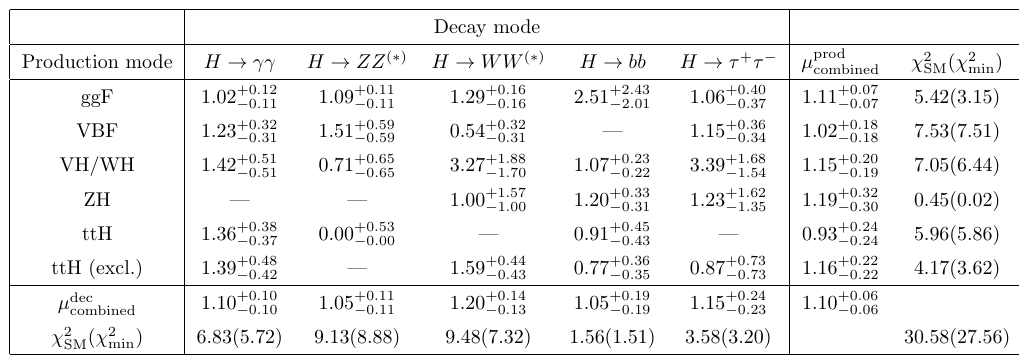
Table 2 . (LHC: 7 + 8 TeV) Combined ATLAS and CMS data on signal strengths from table 8 of ref. [11].